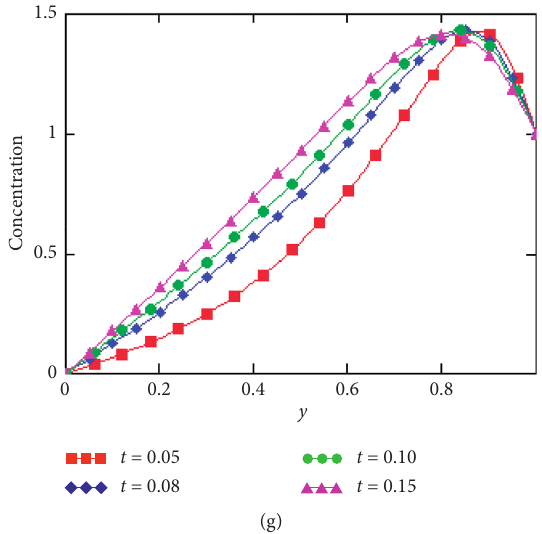
Figure 2: Variation of concentration.